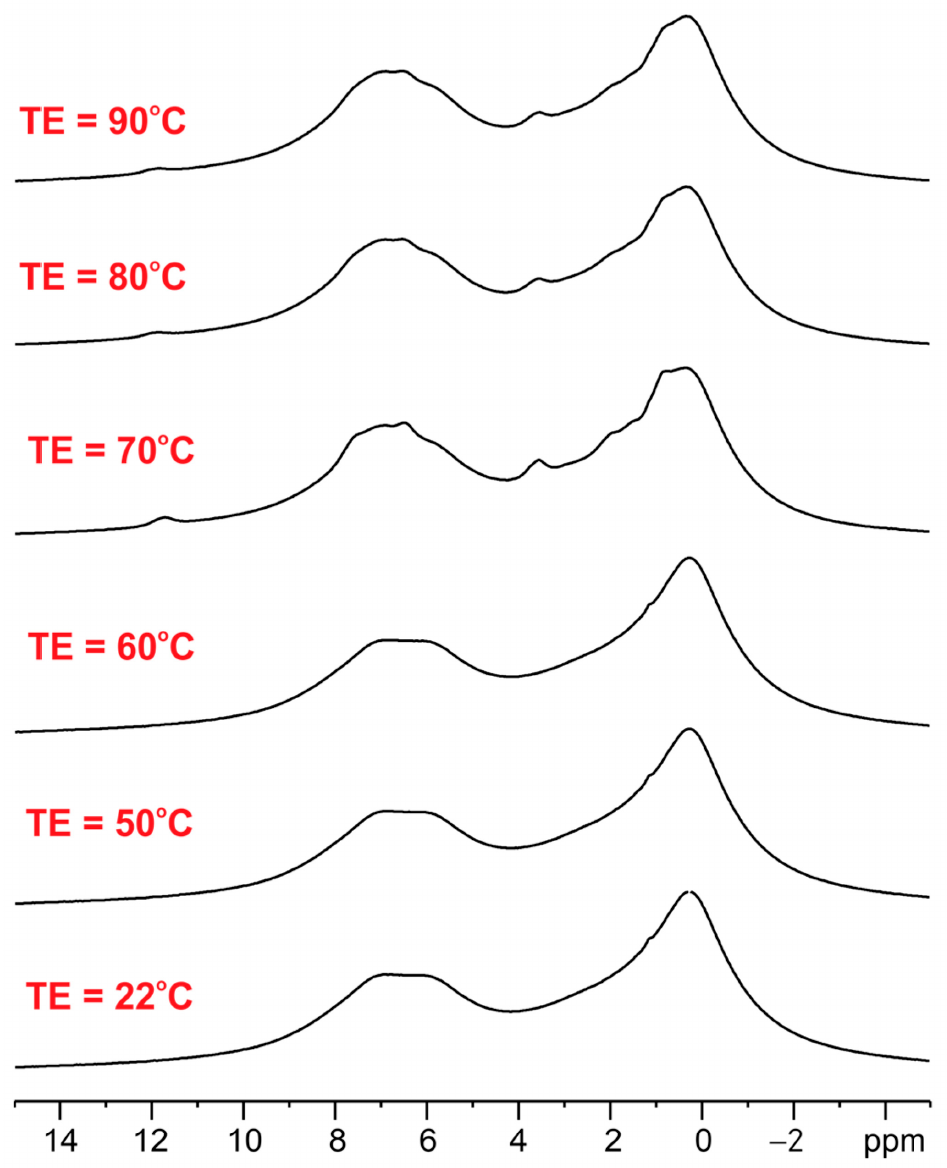
Figure 3. The variable temperature (VT) 1 H MAS spectra of ET crystalline solid recorded with a spinning rate of 8